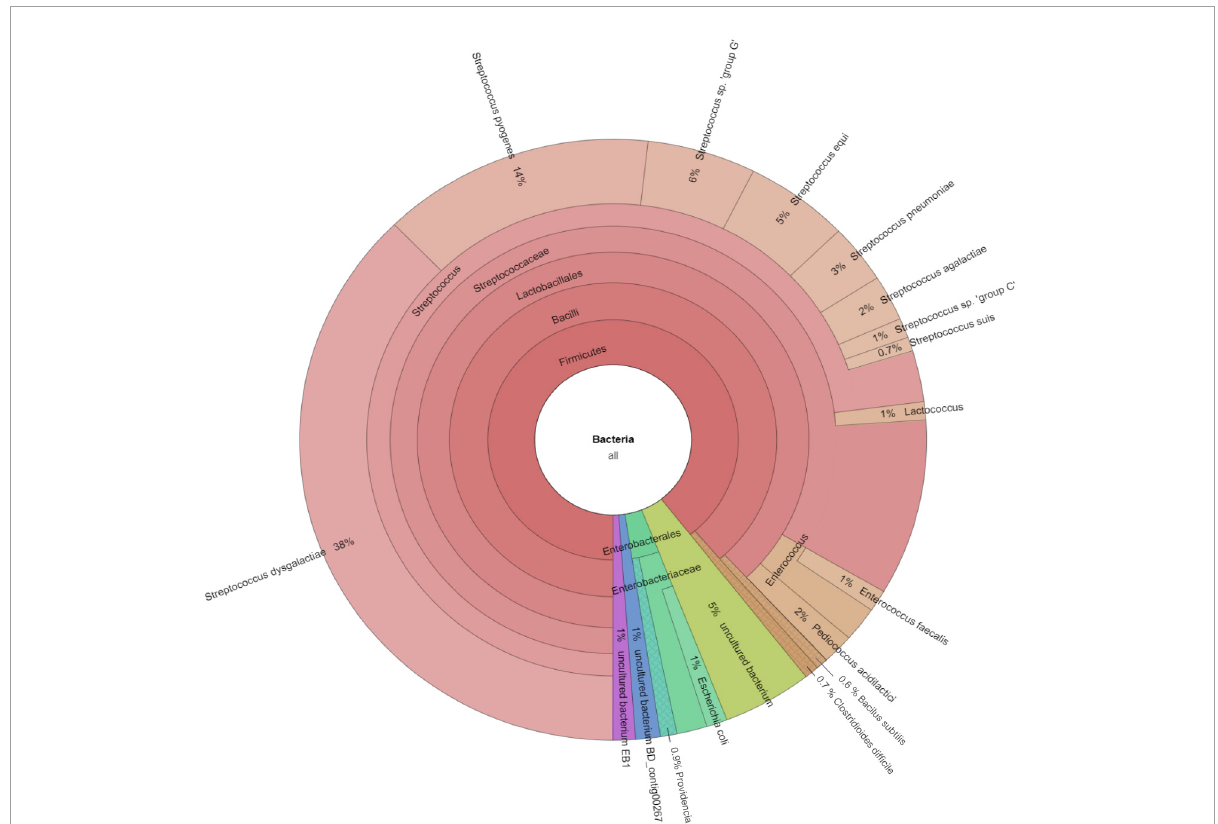
FIGURE4 Metagenomics analysis of the accessory genome of S. dysgalactiae . CCMetagen graph shows the percentage of accessory genes shared with other bacteria. The alignment of accessory genes against the GenBank database using BLAST was performed to trace homolog genes using the CCMetagen analysis tool. The figure and legend were automatically generated based on the nomenclature deposited in the